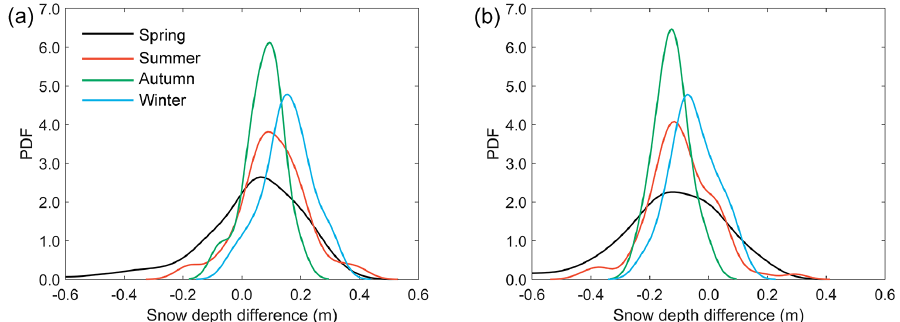
Figure 5. The probability density functions (PDFs) of snow depth estimate differences of the proposed method (a) and the Comiso method (b) by comparing to ASPeCt shipborne data in four seasons. Table 7. The comparisons between the snow depth estimates from the proposed method and in situ measurements from ASPeCt in different sea sectors and seasons. MD: mean difference; MAD: mean absolute difference. Season MD MAD RMSD Correlation Number of (cm) (cm) (cm) coefficient grid cells